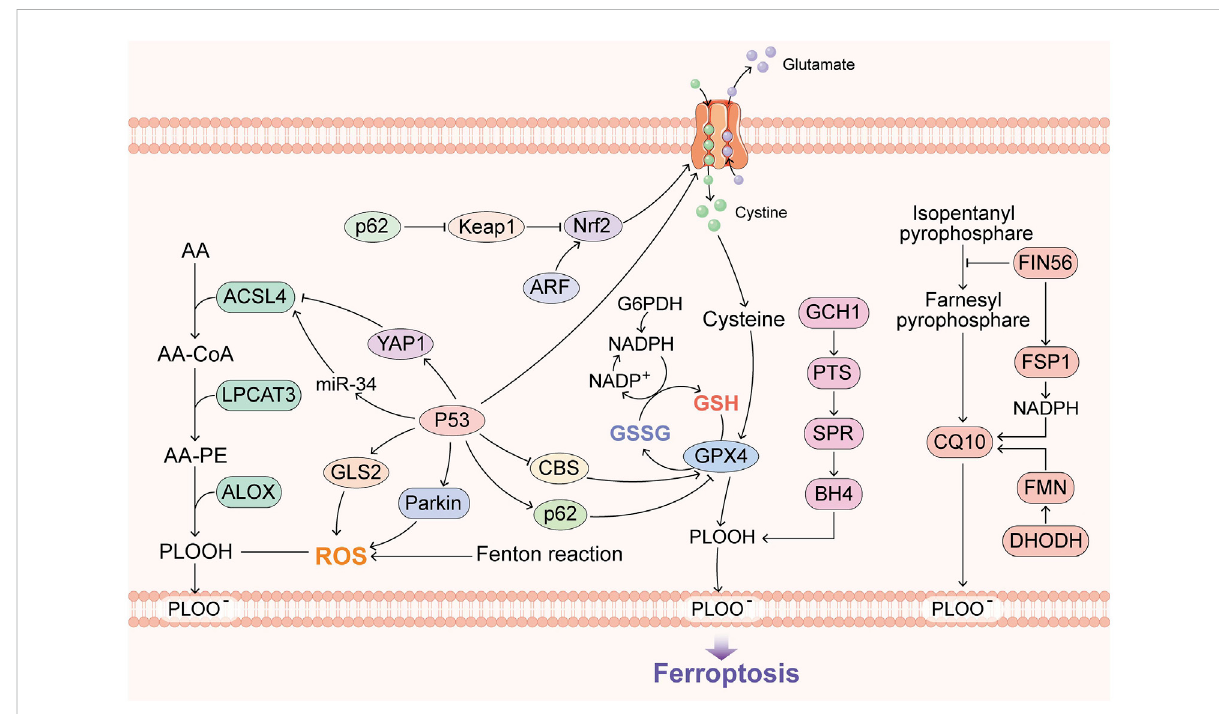
FIGURE 1 Overview of the recent research progress on ferroptosis. GPX4, BH4, FSP1 and DHODH constitute the main defense system of ferroptosis. ACSL4 and the Fenton reaction promote ferroptosis, and p53 has dual roles in